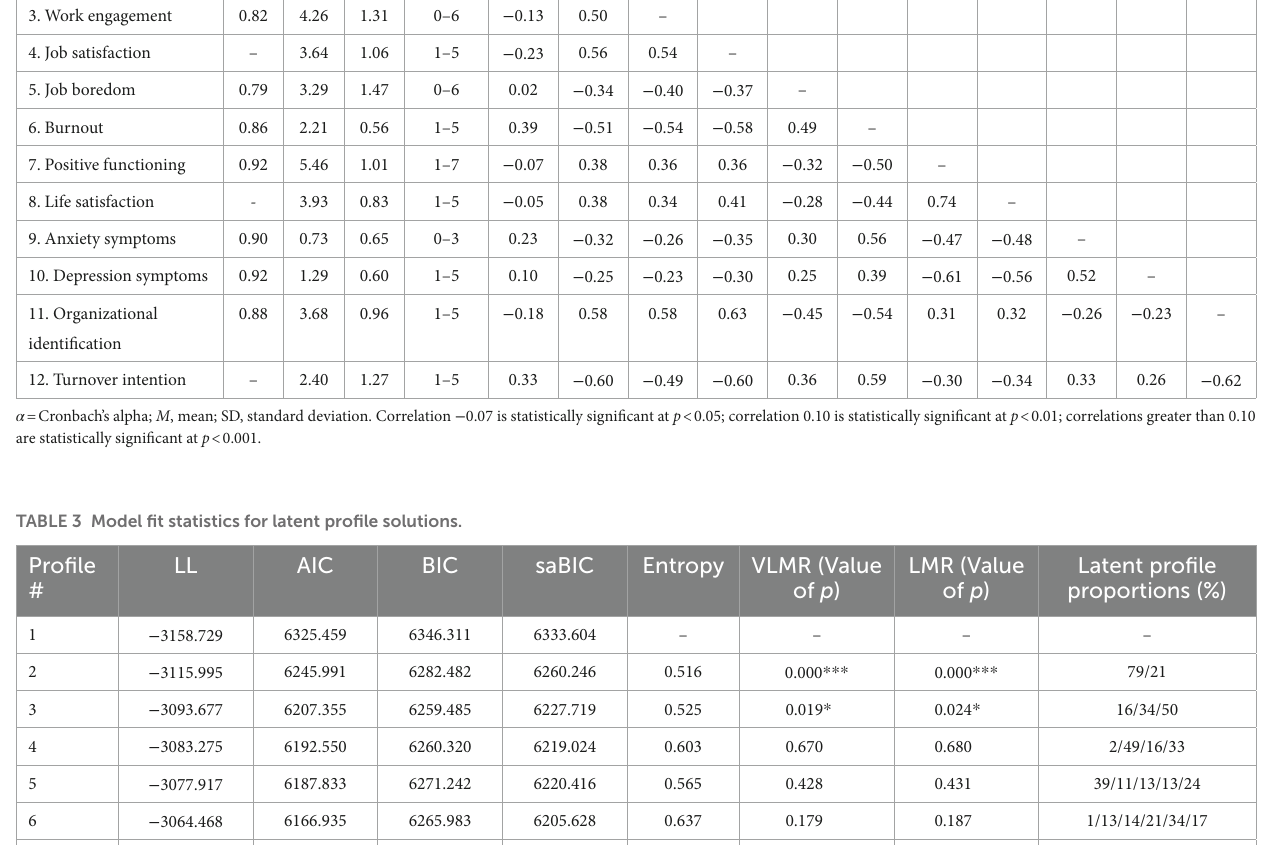
(Table 4). The balanced employees differ from overbenefitting employees by experiencing higher levels of life satisfaction and lower levels of depression symptoms.